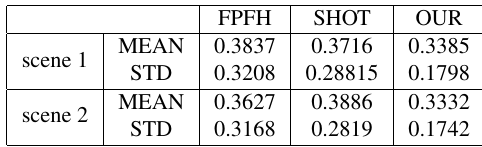
Table 1. Comparison of different